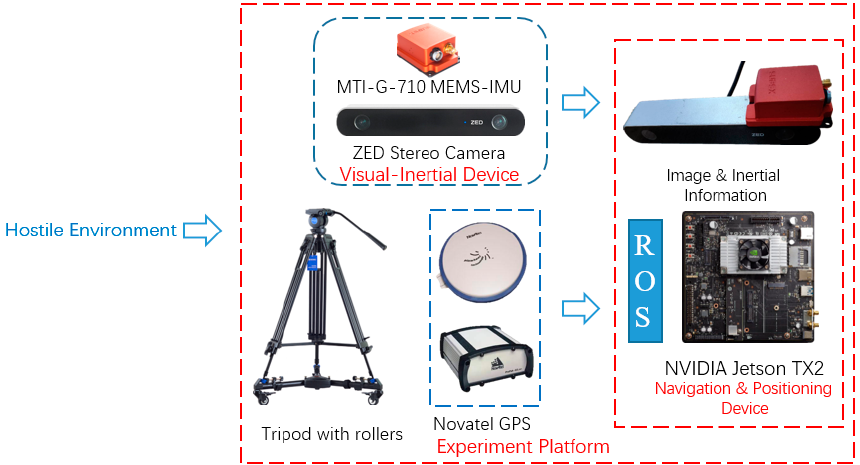
Figure 7. An illustration of platform. It consisted of ZED camera, MTI MEMS-IMU, Novatel GPS and Jetson TX2.